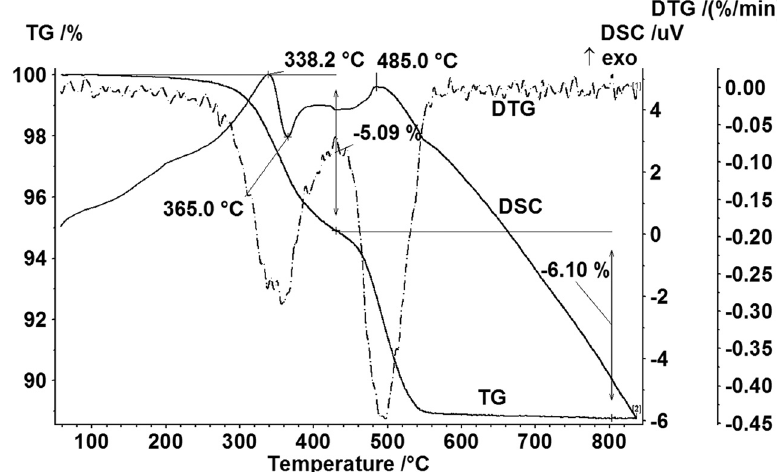
Figure 3: Thermal curves of LCO - 1 sample in a mixture of argon + H 2